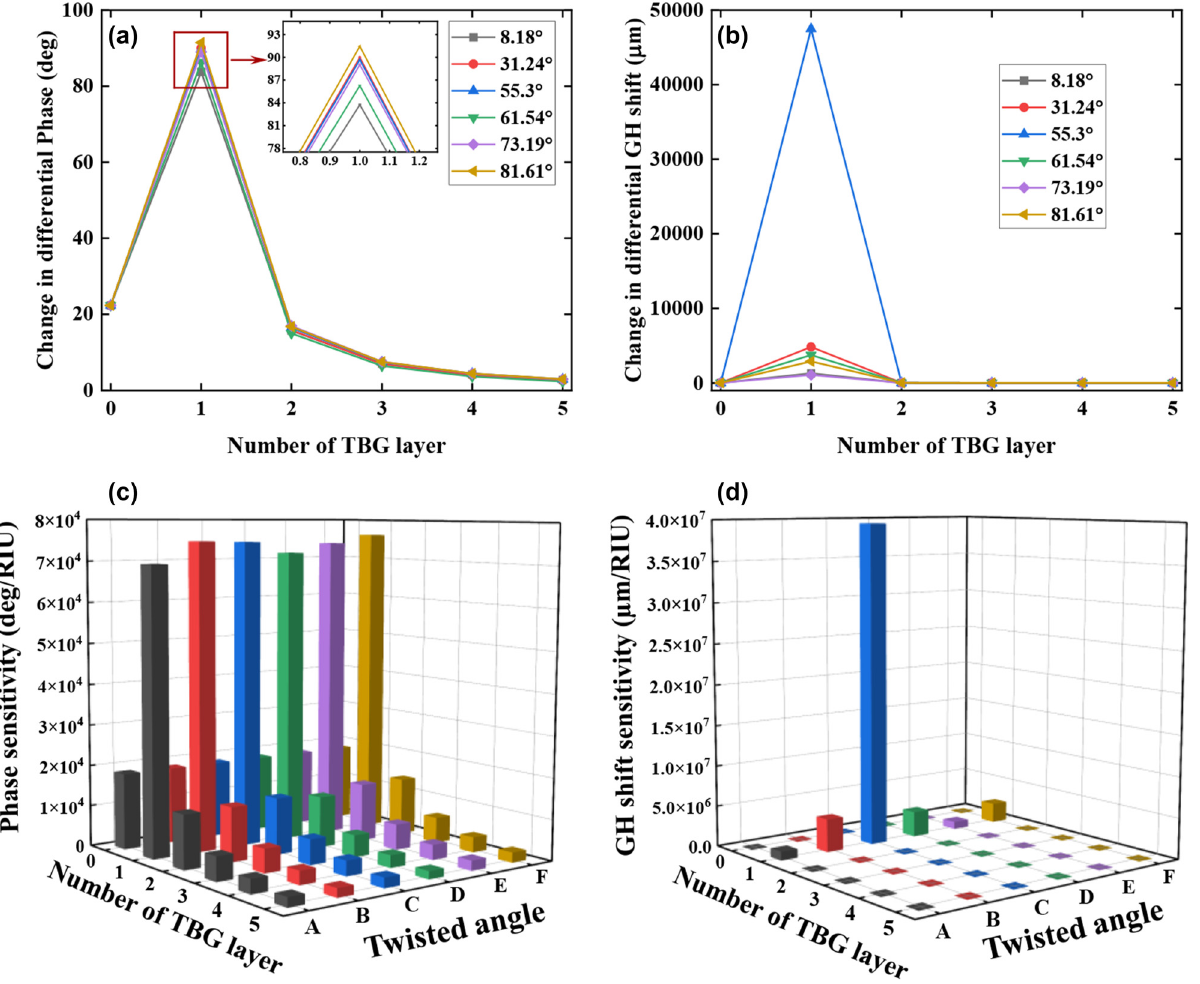
Figure 4: Change in differential phase (a) and differential GH shift (b) by varying the number of TBG system (0–5) and twisted angle (8.18 ◦ , 31.24 ◦ , 55.3 ◦ , 61.54 ◦ , 73.19 ◦ , and 81.61 ◦ ) due to a defined RI variation of 0.0012 RIU. The thickness of Au film is 44 nm, and the excitation wavelength is 632.8 nm. Calculated phase (c) and GH shift (d) sensitivity by varying the number of TBG system (0–5) and twisted angle of TBG (8.18 ◦ , 31.24 ◦ , 55.3 ◦ , 61.54 ◦ , 73.19 ◦ , and 81.61 ◦ ). Notes: The twisted angles of A–F in Figure 4(c) and (d) stand for the angles at 8.18 ◦ , 31.24 ◦ , 55.3 ◦ , 61.54 ◦ , 73.19 ◦ , and 81.61 ◦ , respectively. The running buffers were HEPES, and PBS